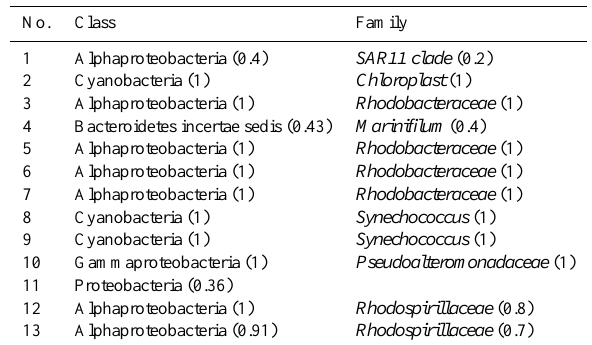
Table 1. Classification of partial 16S rRNA gene sequences (Fig. 7) to bacterial taxa performed with the SILVA classifier (Pruesse et al., 2012). The confidence value (0–1) for assignment at the level of class and genus is given in